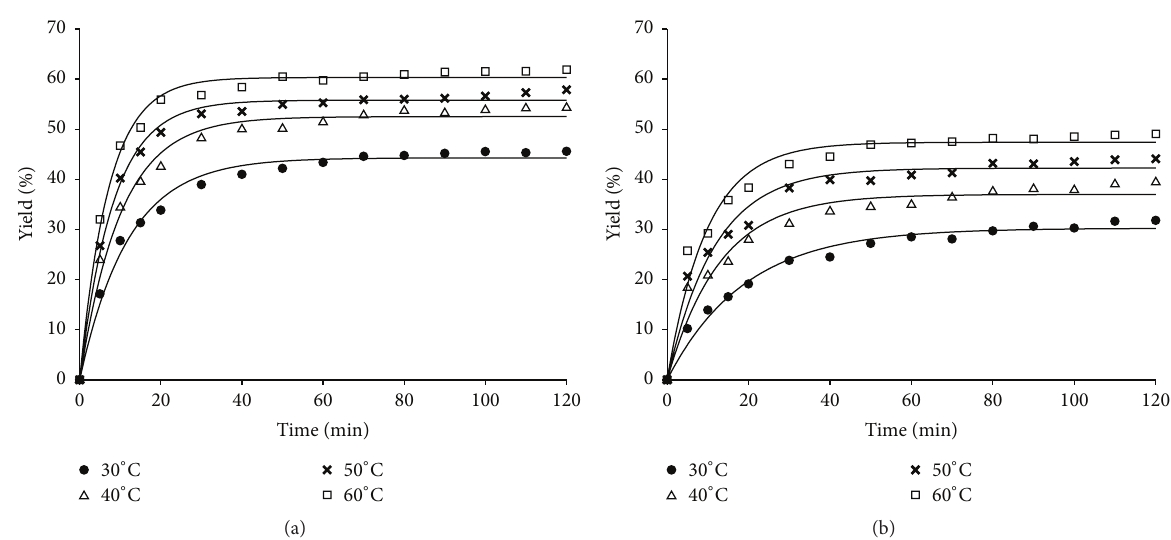
Figure 1: Kinetics of Jatropha oil extraction for an average particle size equal to 0.94 mm and moisture content of 0% (a) and 8.73% (b) at different temperatures.